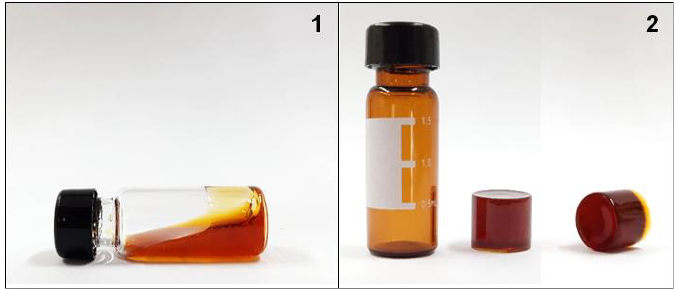
Figure 10. A sample based on the p-(GAT- co -GA)-14 copolymer before (1) and post-curing